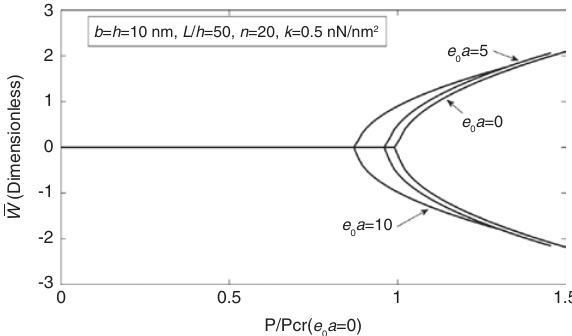
Figure 2: Effect of small scale on the postbuckling behavior of FG nanobeams.